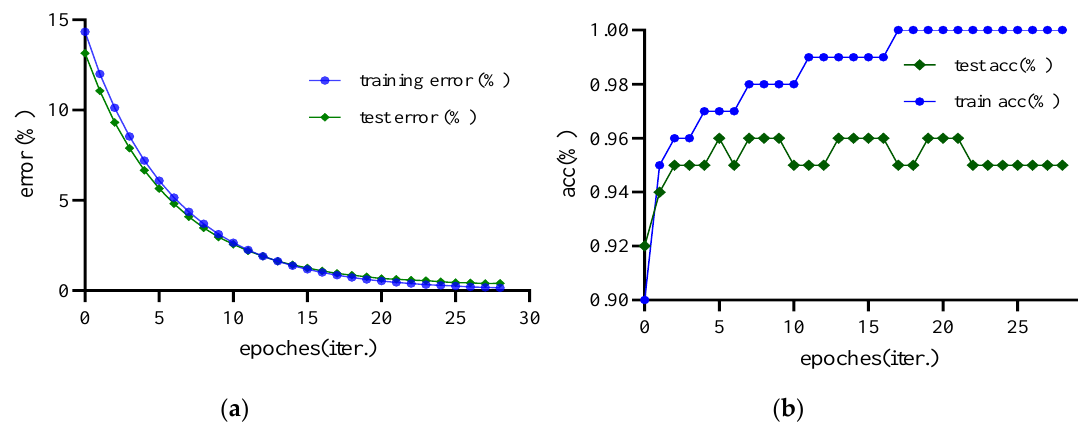
Figure 14. Validation on model training and testing; ( a ) Training and testing errors; ( b ) ACC results on training and testing data sets